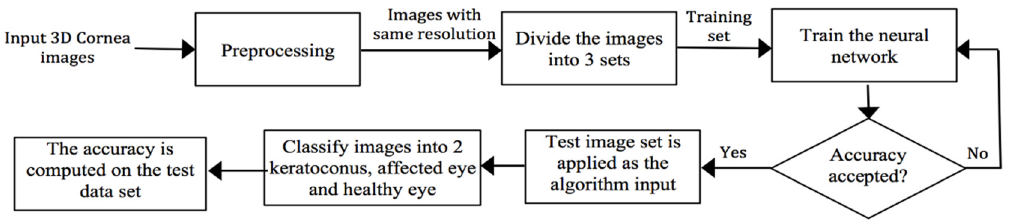
Figure 8. The implementation of the convolutional neural network (CNN).